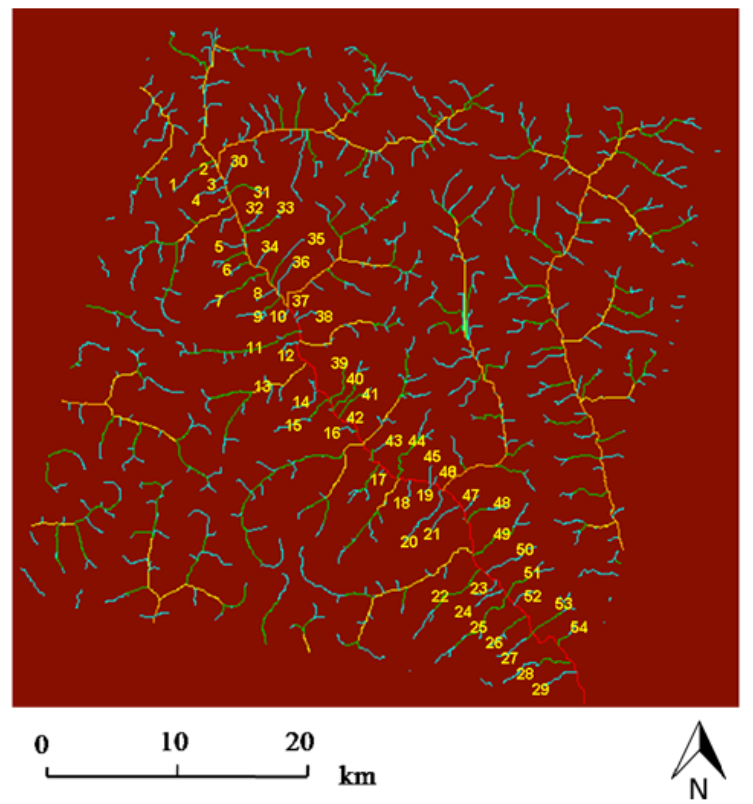
Figure 8. Location of the streams marked with the numbers from 1 to